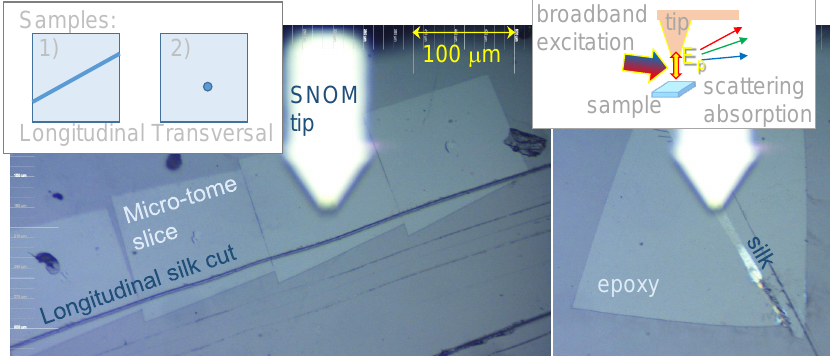
Figure 1. Optical image of longitudinal micro-tome slices of Bombyx mori fibers. Left inset shows schematically the principle of spectrally broadband excitation and detection of scattered light implemented in neaspec tool for detection of nanoscale absorbance and scattering. The excitation light field is p-polarised, E p